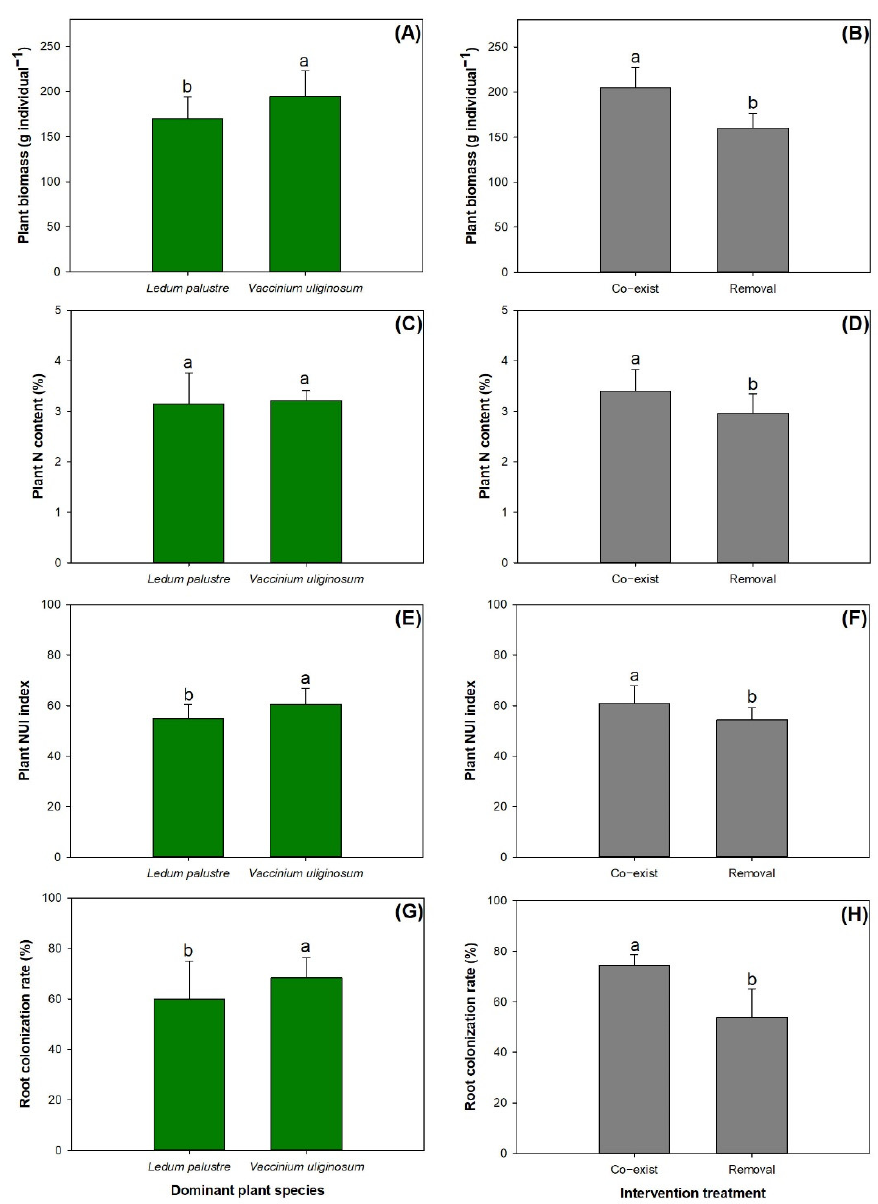
Figure 1. Contrasting levels of plant biomass ( A , B ), nitrogen (N) content ( C , D ), N utilization index ( NUI ) ( E , F ), and root colonization rate ( G , H ) in communities dominated by Ledum palustre vs. Vacciniuim uliginosum (left column) or subjected to the interruption treatment of removal of dominant species vs. the control of co-existence (right column). Columns stand for means with error bars marking standard errors. Different letters label significant difference according to a Tukey test at 0.05